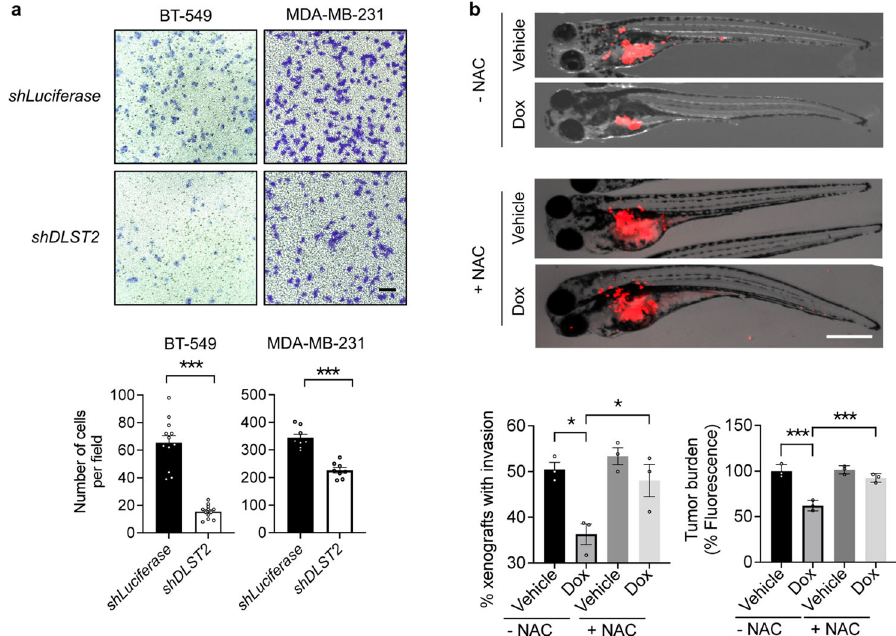
Fig. 6 DLST depletion reduces migration, tumor burden, and invasion of human DLST-dependent TNBC cells. a The representative images (top) and quantitative data (bottom) of transwell cell migration assays for BT-549 and MDA-MB-231 cells in the presence or absence of DLST knockdown: 8 – 13 individual images from triplicated experiments were quanti fi ed for each group. Scale bar = 20 μ m. b Overlay of bright fi eld and RFP channel images of zebra fi sh embryos transplanted with RFP + BT-549 cells at 4 days of post-transplantation with or without NAC treatment (top panels). Quanti fi cation of zebra fi sh xenografts with tumor cell invasion (bottom, left) and burden (bottom, right): the average data from each experimental triplicate (23 – 29 fi sh per group) were presented as an individual dot. Tumor cell invasion was determined for the percentage of zebra fi sh xenografts that have tumor cells migrated away from the original injection site (bottom, left). Tumor burden was quanti fi ed based on the fl uorescence intensity using ImageJ 1.52a (bottom, right). Scale bar = 0.5 mm. Data in ( a , b ) presented as mean ± s.e.m. * P ≤ 0.05, *** P ≤ 0.001. Statistical differences were calculated using one-way